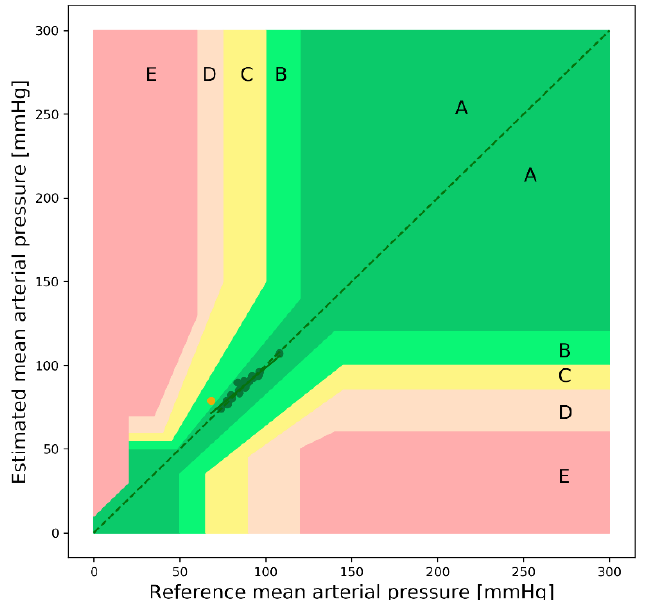
Table 10. Evaluation metrics for SBP, DBP, and MAP (self-made dataset).